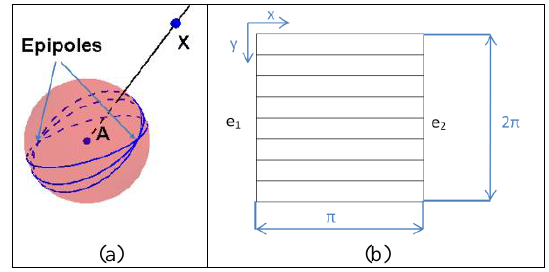
Figure 4. Mapping the spherical image to the rectified image The rectified images look as if the images were taken from cameras which were facing in exactly the same